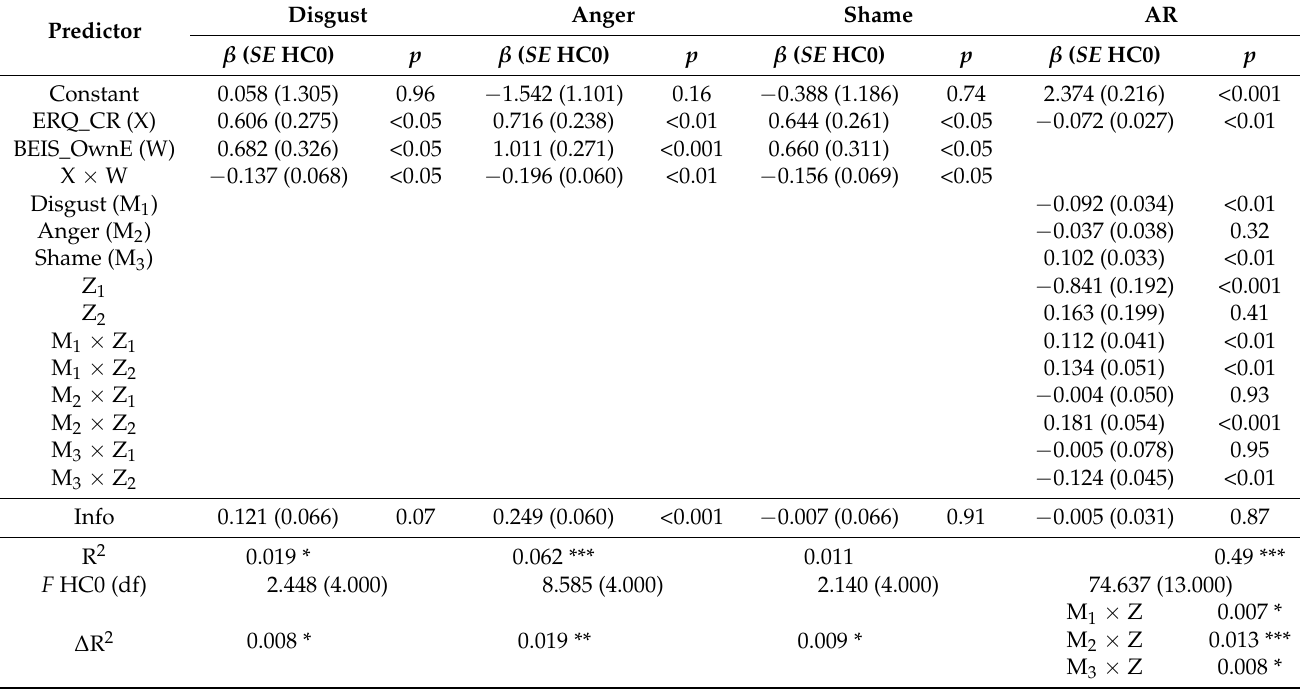
Table 4. Model coefficients for the multiple moderated mediation analysis ( n = 509).